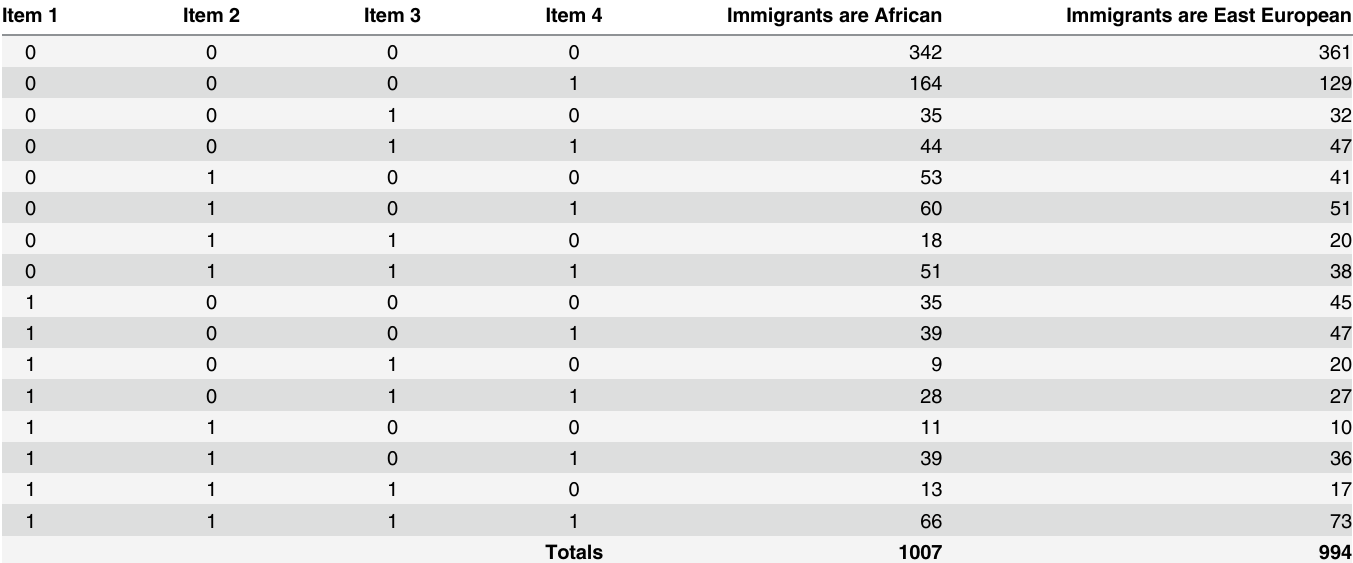
Table 3. 1994 Italian Survey: Stereotype Data (Sniderman, et al., 1995).